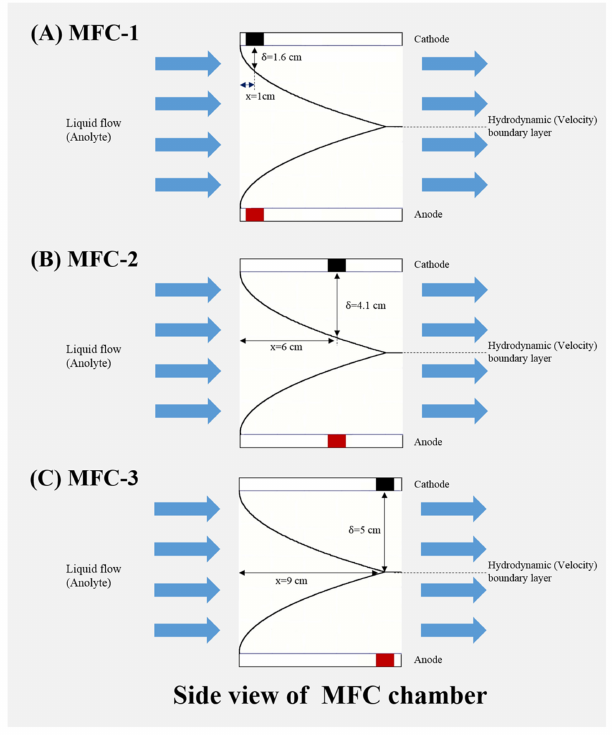
Figure 5. The schematic diagram of hydrodynamic boundary layer in the